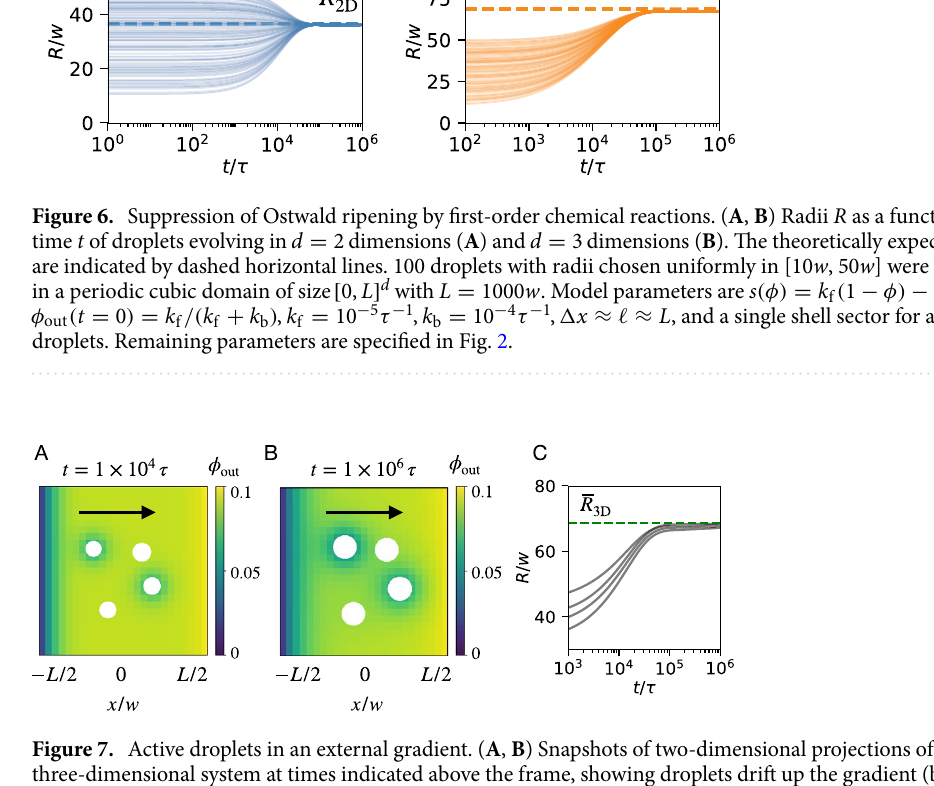
Figure 7. Active droplets in an external gradient. ( A , B ) Snapshots of two-dimensional projections of the three-dimensional system at times indicated above the frame, showing droplets drift up the gradient (black arrow). White circles denote droplets while color indicates the volume fraction in the background field. ( C ) Droplet radius R as a function of time t indicating that all droplets reach R 3D (dashed line); compare to 0.8 R 0 , 1.2 R 0 Fig. 6. ( A – C ) Four droplets with radii chosen uniformly from were placed in a cubic Cartesian [ ] L L L 3 with boundary conditions φ ) ) , L 0 and φ out ( x 0.1 to impose domain of size out ( x = − 2 2 ] 2 2 = = [− = the gradient and no-flux boundary conditions at the remaining system boundaries. Model parameters are ℓ � s φ) R 0 40 w , s (φ) L 10 3 w , � x k f ( 1 k b φ , φ out ( t 0 ) k f /( k f k b ) , k f 10 − 5 τ − 1 and ≈ ≈ ≈ = = = − − = = + = k b 10 − 4 τ − 1 . Remaining parameters are specified in Fig. =